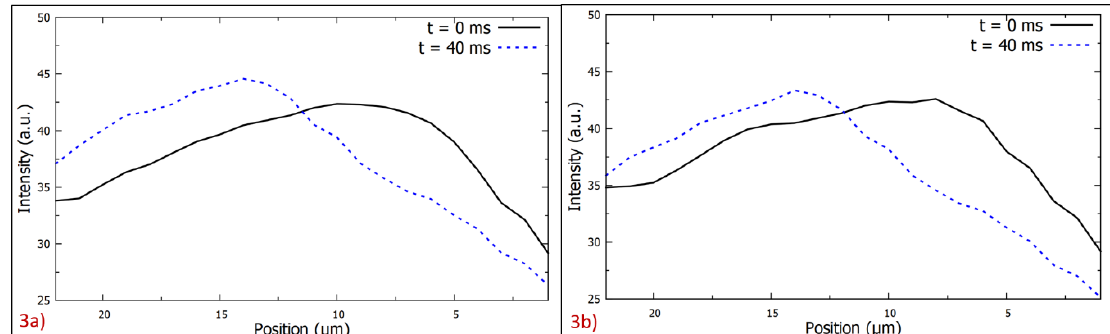
Figure 3. Light intensity as a function of the pixel position at t = 0 ms, when negative DEP was applied, and at t = 40 ms ( a ) for the ssDNA sequence 5’ -(biotin) TGTTGTGCGG- 3’ , which corresponded to the results shown in Figure 2, and ( b ) for the ssDNA sequence 5’ -(biotin) TGTTGTGCGA- 3’ in 10 µL at the frequency 0.5 MHz. The convex edge of the electrode is located on the right side of the polystyrene microspheres (PM) layer, as shown in Figure 2.